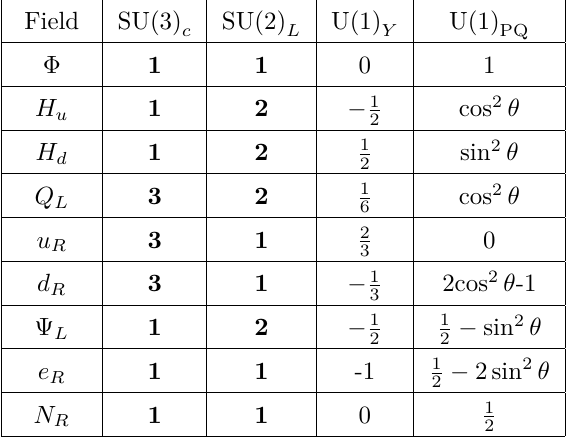
Table 1 . Charge assignment and group representation of the fields in the